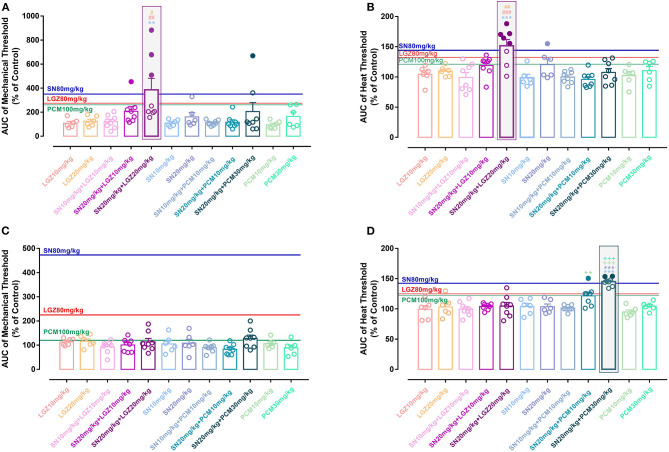
Area Under Curve (AUC) normalized with control (vehicle animals) for the effects of single or combined therapies of SN, LGZ, and PCM at different dosages against mechanical and heat hypersensitivities in rats with incisional pain (A,B), or in mice with carrageenan induced inflammatory pain (C,D). N = 6–8 animals, data were presented as mean ± SEM. Blue, red, or green lines represent the average AUCs of mechanical/heat thresholds for SN 80 mg/kg, LGZ 80 mg/kg, or PCM 100 mg/kg treatment, respectively. Filled circles indicating AUCs of drug combinations were larger than the average AUCs of effective single drug treatments (SN 80 mg/kg and LGZ 80 mg/kg). AUCs of drug combinations were compared with SN (at 10 or 20 mg/kg, **P < 0.01, ***P < 0.001, significant differences with specific groups were illustrated by respective representing colors), LGZ (at 10 or 20 mg/kg, #P < 0.05, ##P < 0.01, ###P < 0.001, significant differences with specific groups were illustrated by respective representing colors); or PCM (at 10 or 30 mg/kg, ++P < 0.01, +++P < 0.001, illustrated by respective representing colors), using Bonferroni's multiple comparisons test following ANOVA. Gray shaded area marked the significant (and most effective) dosage combination for the combined drug therapies.